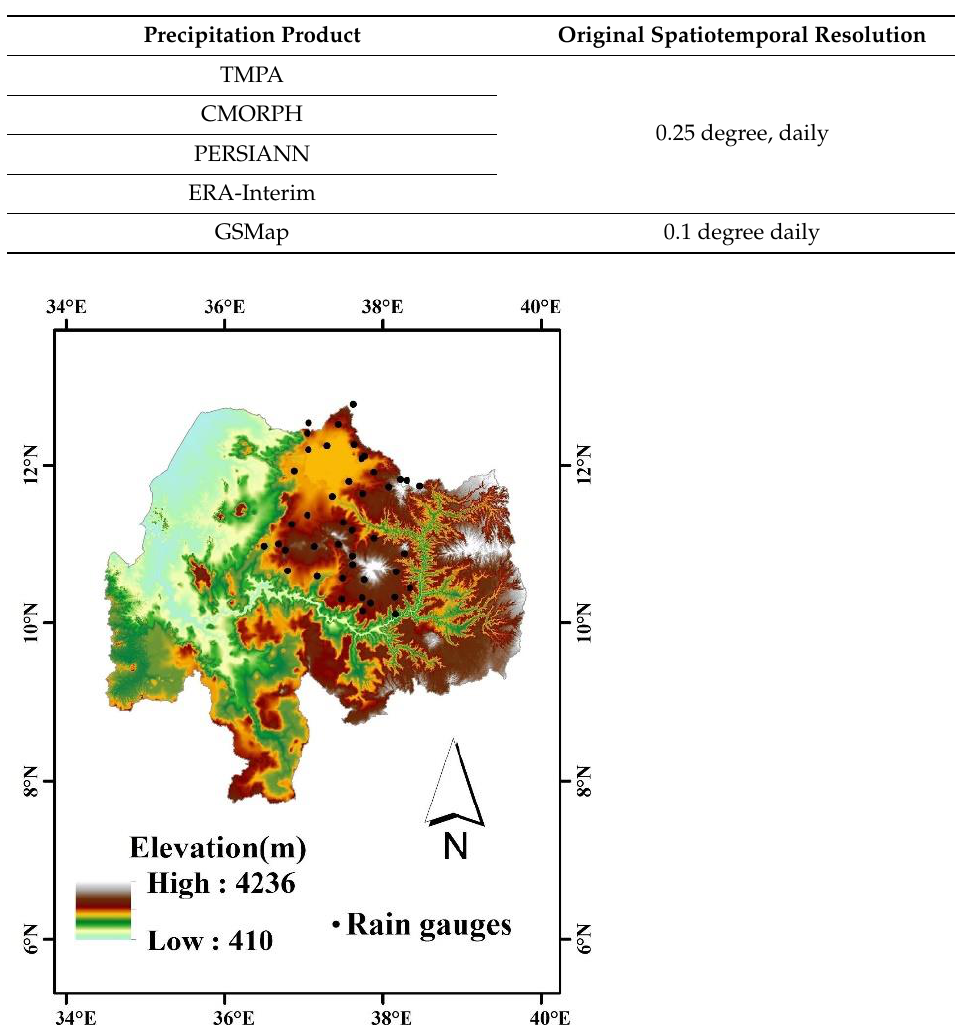
Table 1. Spatiotemporal resolution of different precipitation products used in this study.